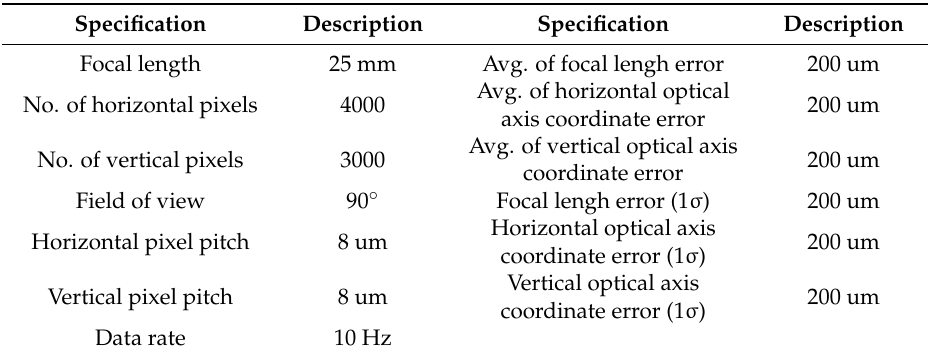
Table 2. Vision sensor specification for simulation.